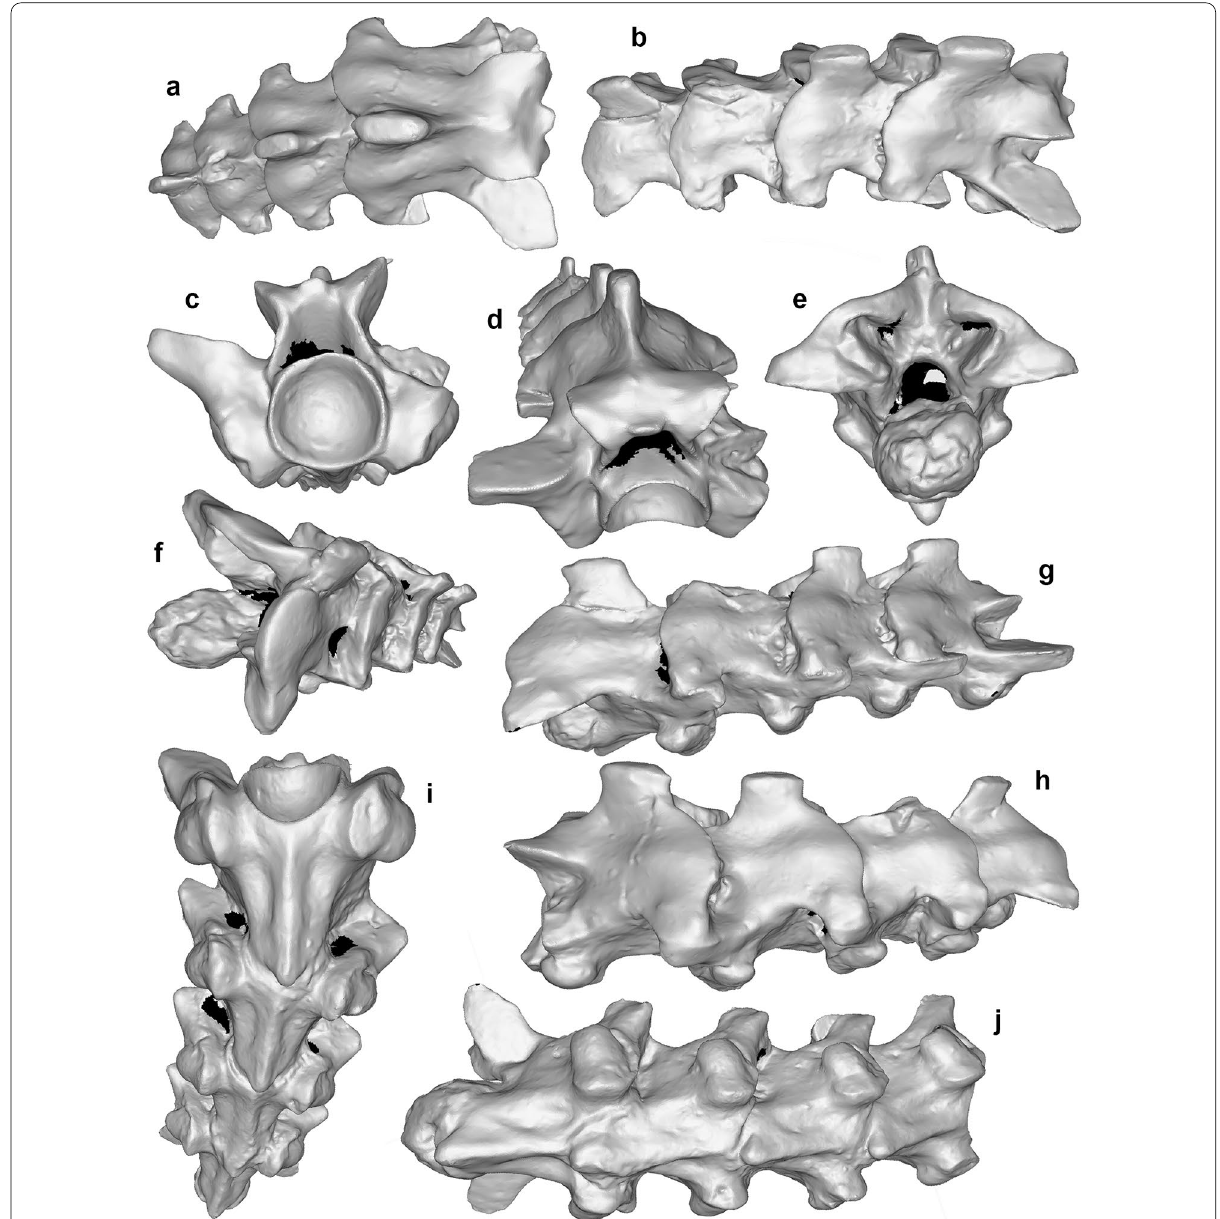
Fig. 49 Eoconstrictor fischeri from Messel, holotype (part) (SMF-ME 929): 3D models of the string of four articulated trunk vertebrae in dorsal ( a ), dorsolateral ( b ), anterior ( c ), anterodorsal ( d ), posterior ( e ), posterodorsal ( f ), right lateral ( g ), left lateral ( h ), ventral ( i ), and ventrolateral ( j ) views. Images not to the same